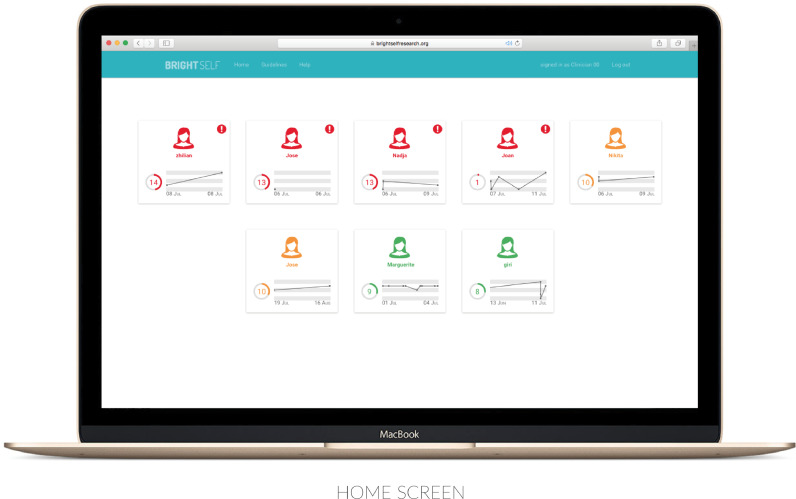
The home screen.